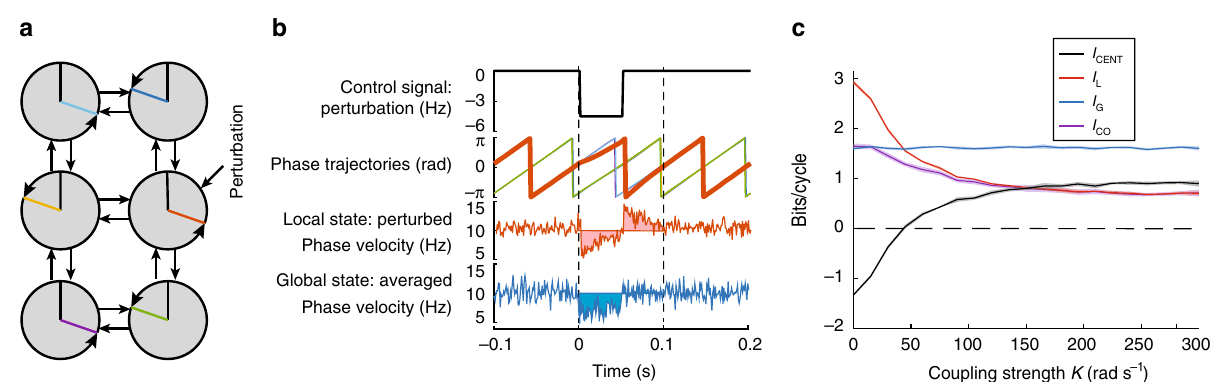
Fig. 2 Centralization of a coupled-oscillator model of locomotion. a We simulated this six phase oscillator network described in Eq. (3) that has been used to model the alternating tripod gait of cockroaches. b The control signal was a perturbation to a single oscillator with random amplitude. The local oscillator phase, shown in red, deviates more than other oscillators. The local state was the integrated absolute deviation from baseline of the phase velocity of the perturbed oscillator, shown by the shaded red region. The global state was similarly calculated from the average phase velocity. c For a range of coupling strengths K we calculated the mutual information between the pulse height of the perturbation and the local ( I L ) and global states ( I L and I G , respectively). The shaded regions show the uncertainty in the estimate of mutual